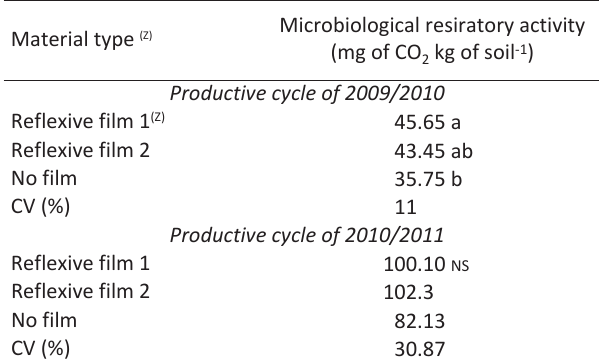
Table 10 - Microbiological respiratory activity of the soil accor- ding to the material type addopted for Merlot vines, in productive cycle 1 (2009/2010) and productive cycle